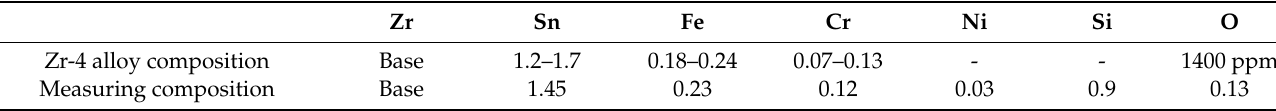
Table 1. Chemical composition (in wt.%) of the zircaloy-4 substrates. Zr